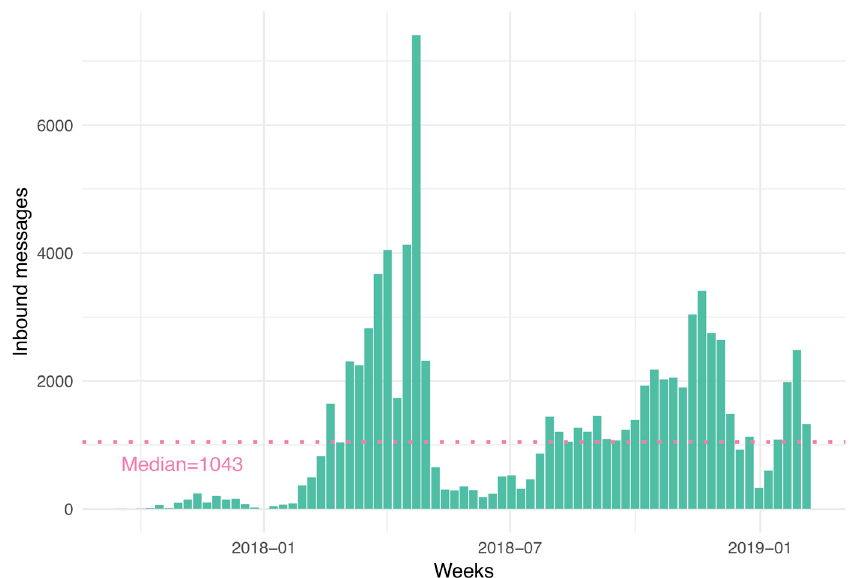
Figure 1. Volume of inbound messages per week.